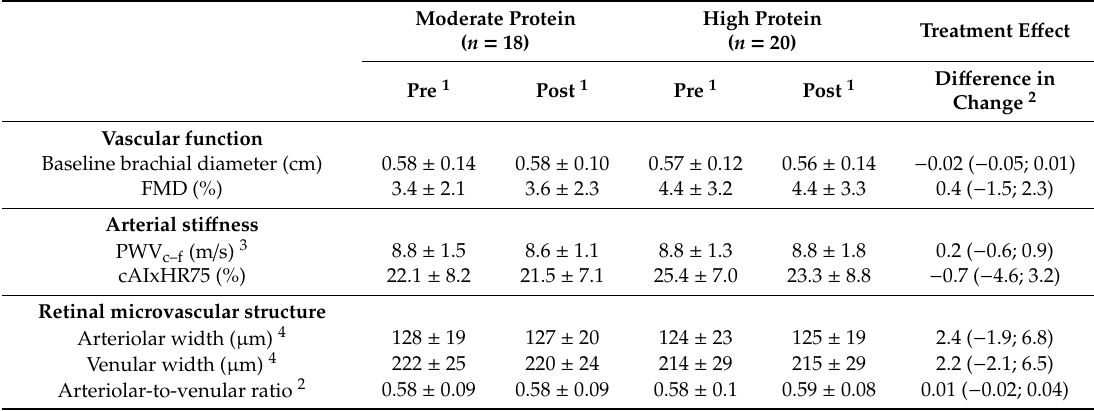
Table 3. Vascular function measurements at pre- and post-respiration chamber time points with a moderate- or high-protein dietary diet.